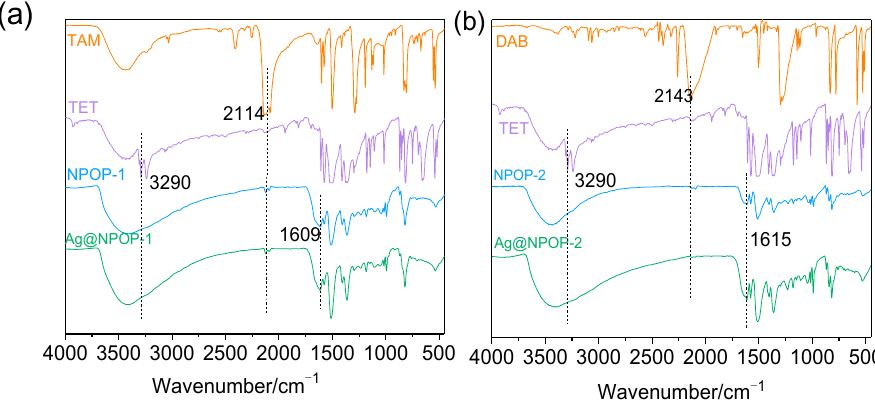
and Ag@ Figure 1. FT-IR spectra of: ( a ) TAM, TET, NPOP-1, and Ag@ NPOP-1, ( b ) DAB, TET, NPOP-2 and Ag@ NPOP-2.